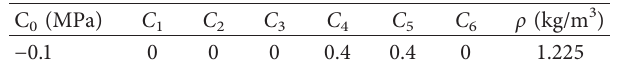
Table 2: Air material parameters [22].